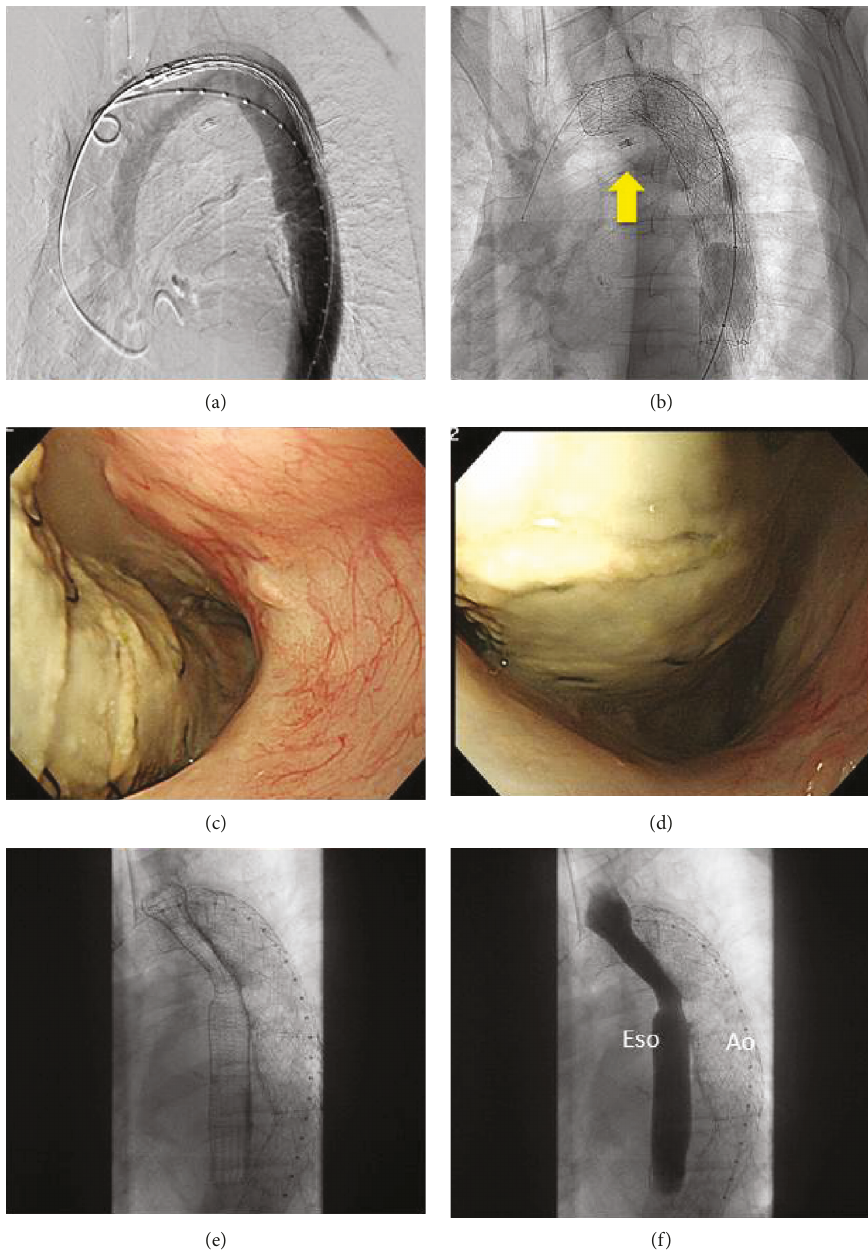
Figure 2: Imaging showed esophageal stenting to repair the aortic stent migration. (a) Aortography showed no active bleeding. (b) Using the marking clips as a reference point, a stent graft was inserted to control the massive esophageal bleeding (yellow bold arrow). (c) Esophagogastroduodenoscopy revealed that the aortic stent is exposed into the esophagus. (d) The stent narrowed the esophageal lumen, hindering the scope ’ s passage past the lesion. (e) An esophageal stent was placed adjacent to the aortic stent to push it out and dilate the esophageal lumen. (f) The contrast medium fl owed smoothly within the esophageal